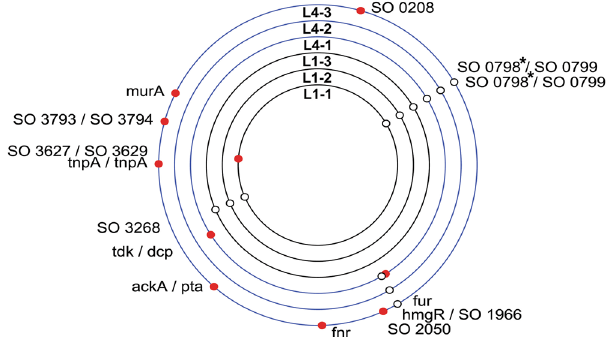
Figure 3. Identification of the chromosomal mutations in six evolved MR-1 strains. The mutations represented by circles are plotted on the circular chromosome of each clone. A red circle denotes a mutation that is unique to the clone. * Promoter under Fur